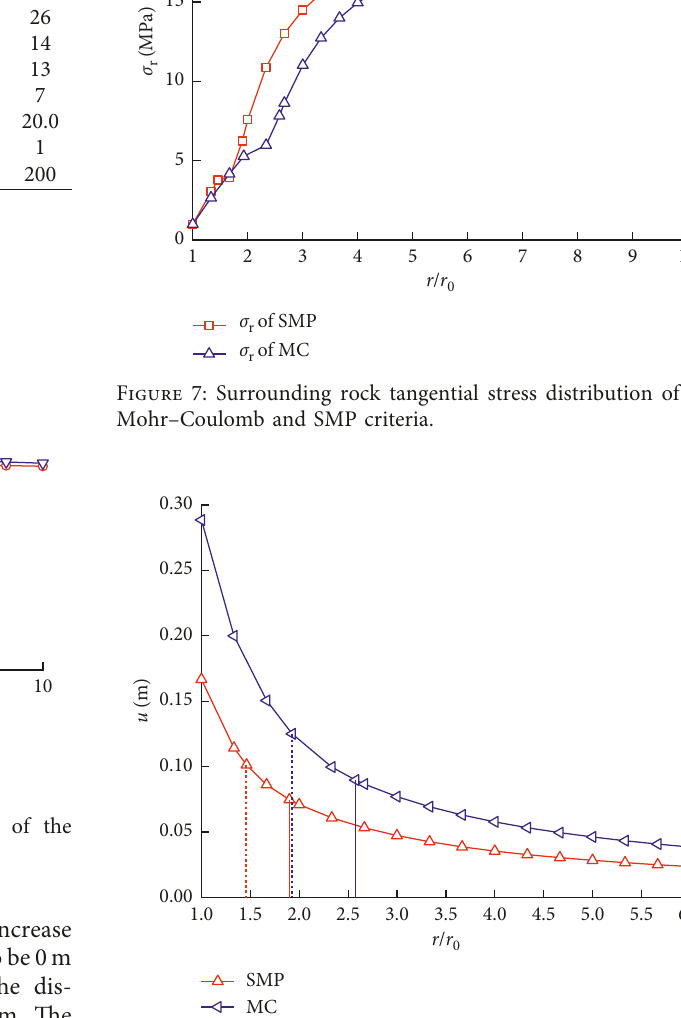
Figure 8: Plastic zone radius and displacement of the Mohr– Coulomb and SMP